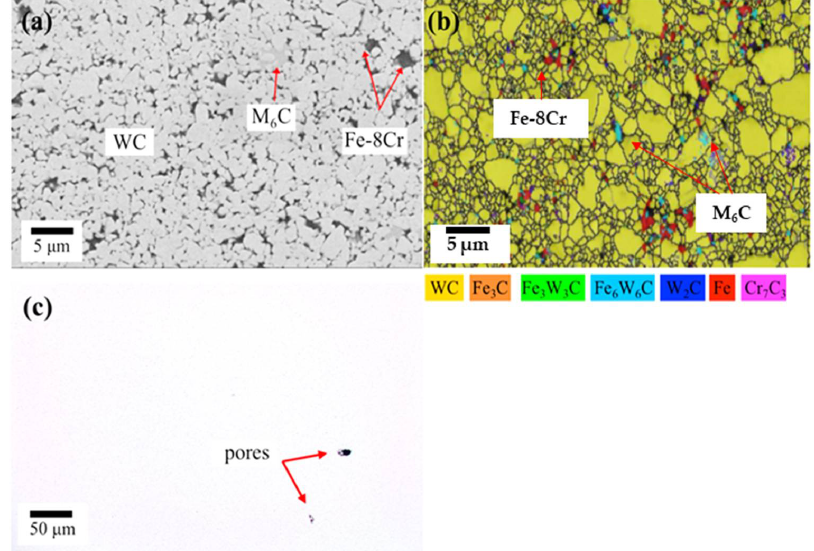
Figure 2. ( a ) SEM image in SE mode of untreated WC-Fe-8Cr cWC. M 6 C is present as an intermediate contrast between high-Z WC (light grey) and low-Z Fe-8Cr (dark grey). Image ( b ) shows an EBSD phase map showing the WC (yellow) and BCC binder pools (red) along with M 6 C (Fe 3 W 3 C). Unindexed points are shown in grey. ( c ) Light microscopy image showing presence of pores.